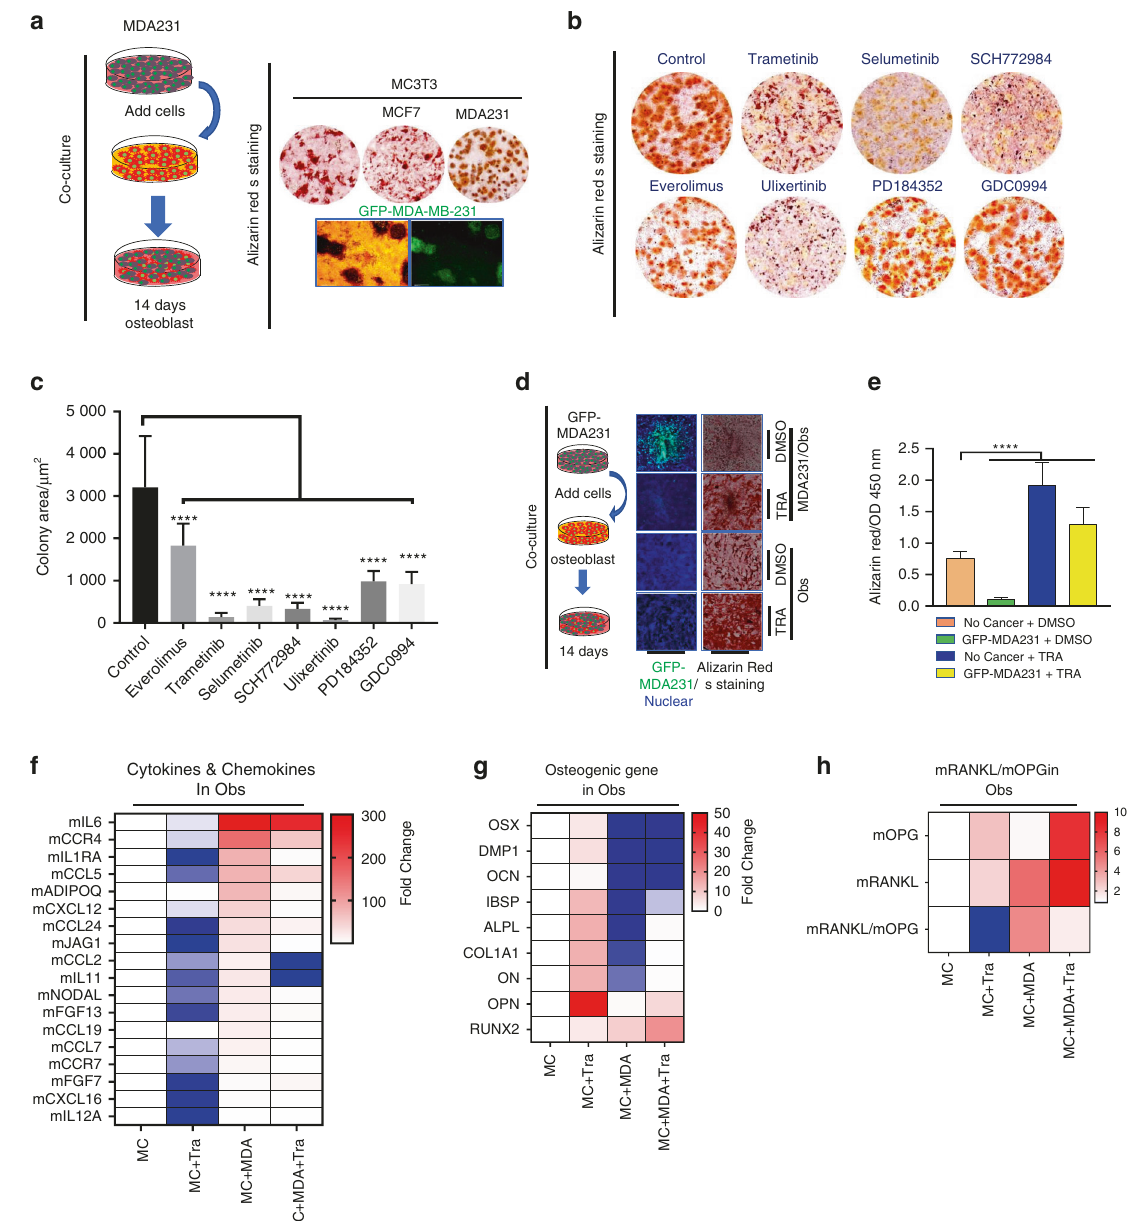
Fig. 5 Pharmacologic inhibition of ERK1/2 induces bone formation and reduces osteoclastogenic cytokine expression in osteoblast-associated BCCs. a Clinically aggressive BCCs highly expressive of pERK1/2 inhibit preosteoblast maturation. The MDA-MB-231 cells are labeled with GFP. b Pharmacologic inhibition of ERK1/2 phosphorylation restores osteoblastic mineralization during differentiation from osteoblast precursor cells; both processes are impaired in the presence of highly pERK1/2-expressing BCCs. Alizarin Red S staining and quanti fi cation of cancer cells 14 days after treatment with dimethyl sulfoxide (DMSO) or the indicated inhibitors. MEKi; trametinib 40 nmol·L − 1 (GSK1120212), selumetinib 300nmol·L − 1 (AZD6244) and PD184352 300nmol·L − 1 , ERKi; ulixertinib 600nmol·L − 1 , SCH772984 100nmol·L − 1 and GDC-0994 40 nmol·L − 1 , mTORC1i; everolimus 40 nmol·L − 1 (RAD001). c Quanti fi cation of the mean tumor colony area based on the pharmacologic pERK1/2 inhibition experiment in ( b ). Statistical analysis by one-way ANOVA with Dunnett ’ s multiple comparisons. d Osteogenic differentiation was determined using Alizarin Red S staining, which revealed that trametinib not only inhibited BCC growth but also induced bone formation. MDA-MB-231 cells were labeled with GFP for visualization. e Alizarin Red S staining quanti fi cation in images from the experiment in ( d ). Statistical analysis was performed by one-way ANOVA with Dunnett ’ s multiple comparisons. f Differential heat map of in fl ammatory cytokine, chemokine, and growth factor expression in osteoblasts cocultured with MDA231 cells in the presence of trametinib. g Differential heat map of osteogenic gene expression in osteoblasts cocultured with MDA231 cells in the presence of trametinib. h Differential heat map of RANKL/OPG ratio changes among osteoblasts treated with pERK1/2 targeting reduces cancer-induced bone destruction the same BCC lines and trametinib successfully normalized the in vivo RANKL/OPG ratio (Fig. 5h). Together, these results suggest that Translational investigation of the aforementioned in vitro fi ndings ERK1/2 activation in osteoblasts inhibits mineralization and was pursued to determine the extent to which available pERK1/2 promotes osteoclastogenic cytokine expression. Moreover, MEK inhibitors protect tumor-laden bones from osteolysis in living inhibitors may protect bone by restoring skeletal homeostasis.